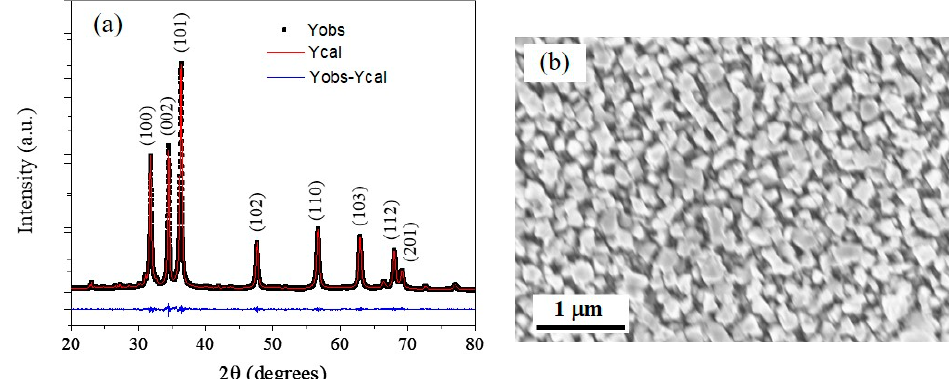
Figure 1. ( a ) X-ray diffraction pattern and ( b ) scanning electron microscope image of zinc dross originated ZnO nanoparticle film. originated ZnO nanoparticle